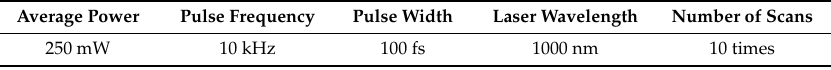
Table 1. Relevant parameters of Libra-HE femtosecond laser